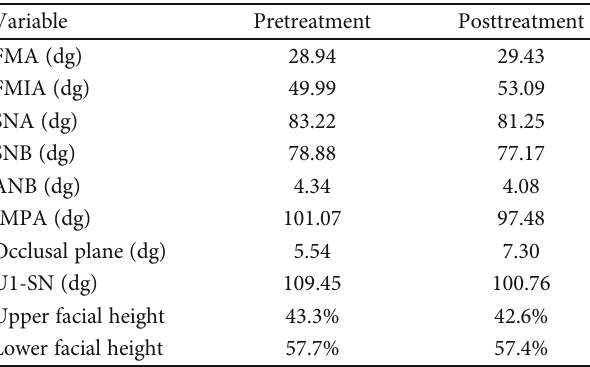
Figure 2: Initial treatment records prior to bonding with her previous orthodontist from two years ago. Table 1: Cephalometric